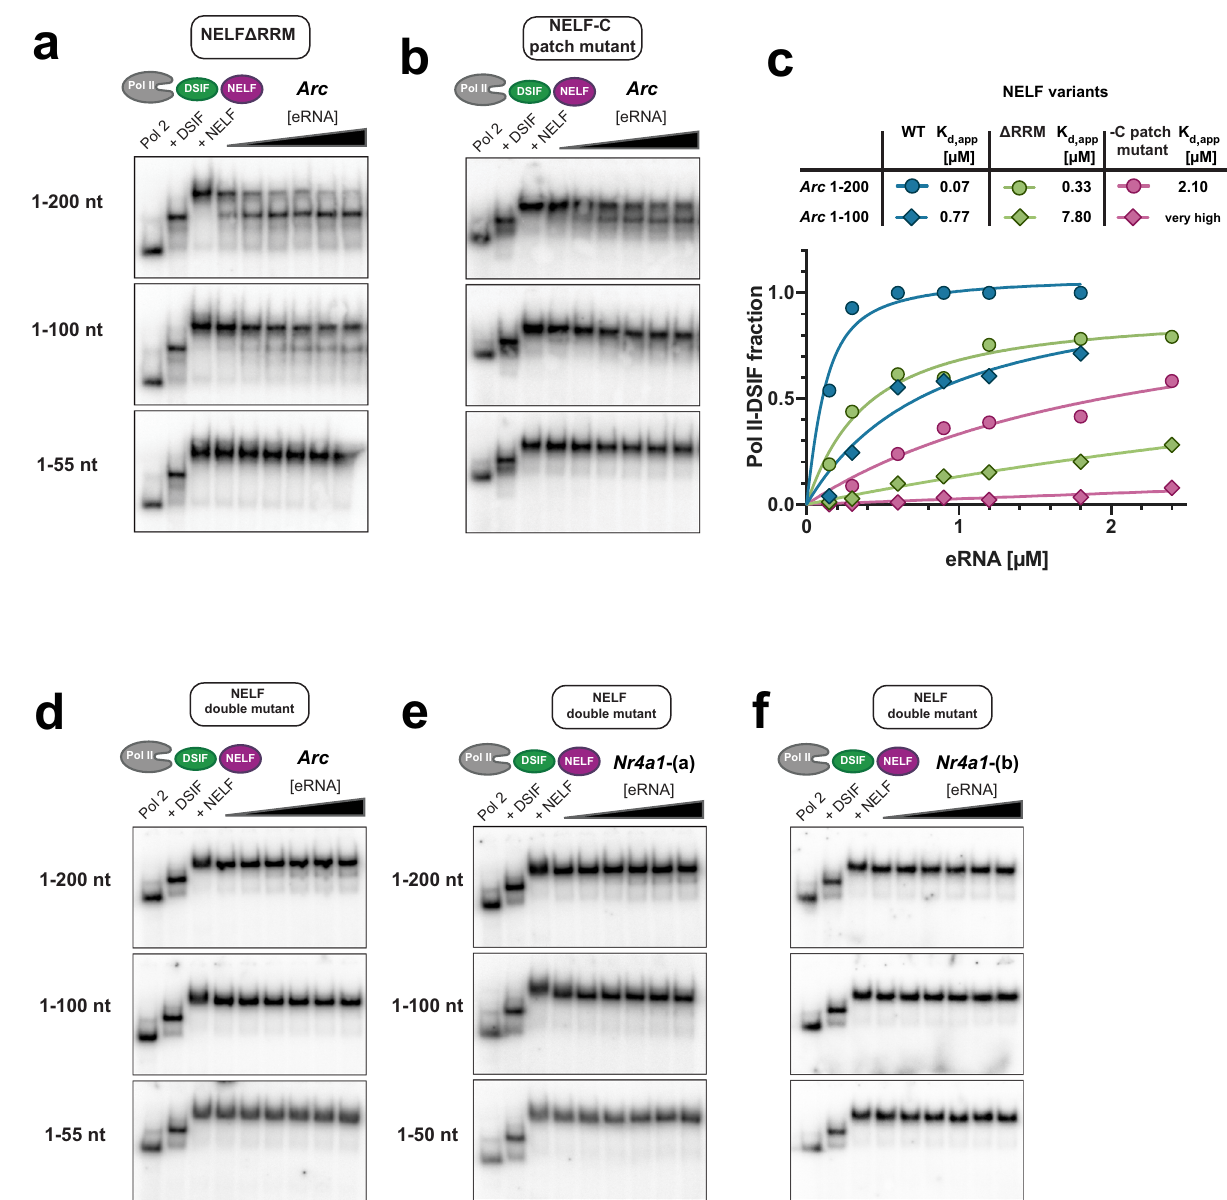
Fig. 3 Positive patches on NELF-AC and the NELF-E RRM domain are both involved in eRNA-driven NELF dissociation. EMSAs carried out with PEC variants that comprise a the NELF-ABC-E Δ RRM complex (NELF Δ RRM), or b a mutant NELF – ABCE complex, in which lysines and arginines situated in positively charged surface patches on NELF-C are mutated to uncharged residues (R291Q, K315M, K371M, K372M, K374M, K384M, K388M, R419Q, and R506Q) (NELF-C patch mutant) 42 , c Quanti fi cation of NELF release using data from a , b . Data for wild-type NELF (Fig. 2b) are shown to aid comparison. Binding curves were plotted and fi tted as in Fig. 2e. d EMSA using a NELF double mutant (NELF patch mutant + NELF-E Δ RRM). The three NELF mutants utilized in these experiments were described previously 42 . All assays were performed as in Fig. 2b – d, using Arc eRNAs (1 – 50), (1 – 100), or (1 – 200). In e , f EMSAs of the NELF double mutant using Nr4a1 -(a) and Nr4a1 -(b) eRNA fragments are shown, respectively. Source data for ( a – f ) are provided in a Source Data fi